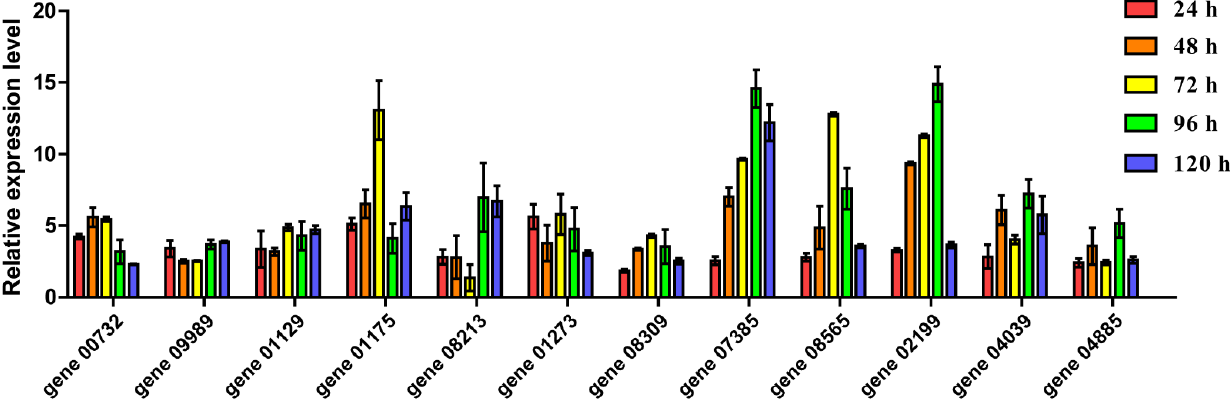
Figure 7. Expression analysis of 12 TF genes at different fermentation times using qRT-PCR. The experiments were repeated three